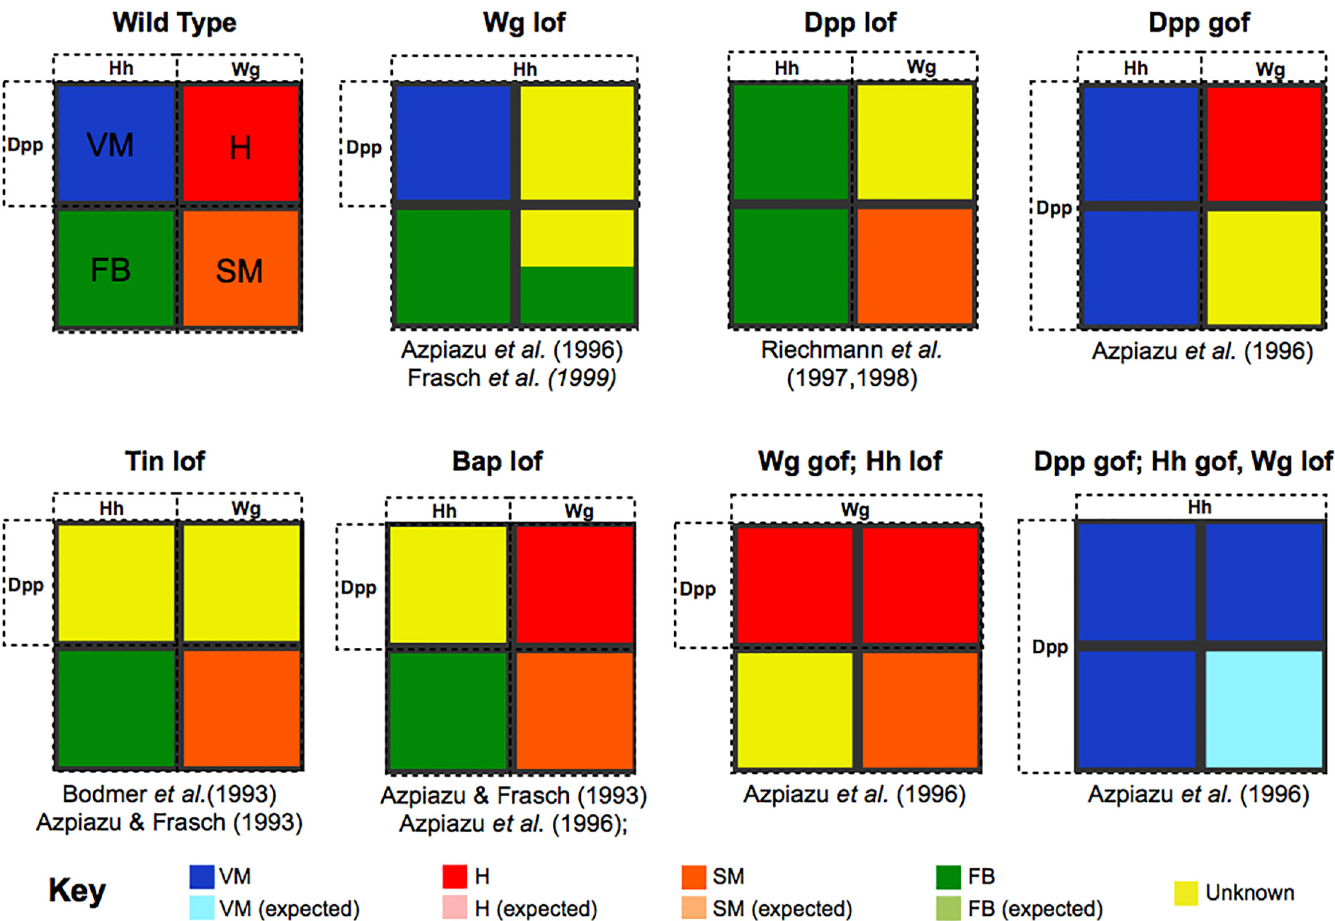
Fig 4. Simulations of known genetic perturbations. The results of selected simulations of loss-of-function (lof), gain-of-function (gof) mutations, and of combination thereof are shown in the form of coloured square vignettes, along with references to articles presenting matching data. The first vignette (top left) correspond to the wild type situation, with VM, H, FB and SM presumptive territories coloured in blue, red, green and orange, respectively. In the following vignettes, the coloration of the four presumptive territories are modified to reflect the absence or important markers, or the combination of markers associated with different tissues. Wg lof leads to the loss of Wg/Slp domain, resulting in an expansion of the En/Hh domain; consequently, the model correctly predicts the loss of H along with a potential perturbation of SM (yellow domains). Dpp lof leads to the loss of dorsal derivatives (VM and H), along with an expansion of FB. Dpp gof leads to an expansion of VM at the expense of FB, along with a perturbation of SM. Tin lof shows a loss of dorsal tissues, while Bap lof exhibits only the loss of VM. Finally, the combination of Wg gof and Hh lof leads to a dorsal expansion of H, along with a loss of FB, while the combination of Dpp gof, Hh gof and Wg lof leads to an expansion of VM in the whole